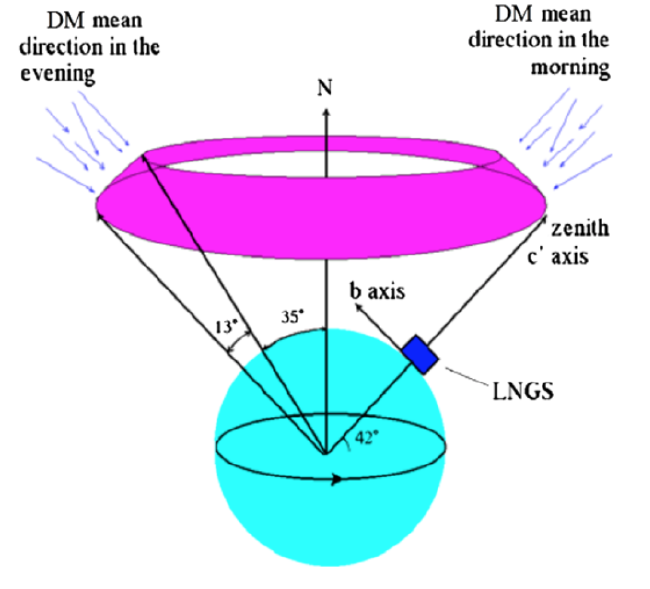
Figure 5. Schematic representation of an anisotropic detector placed at LNGS with the axis in the vertical direction and another axis pointing to the North. The area in the sky from which the dark matter (DM) particles are preferentially expected is highlighted [48,50]. Reprinted from Ref. [48] with Copyright Permission from The European Physical Journal (EPJ).